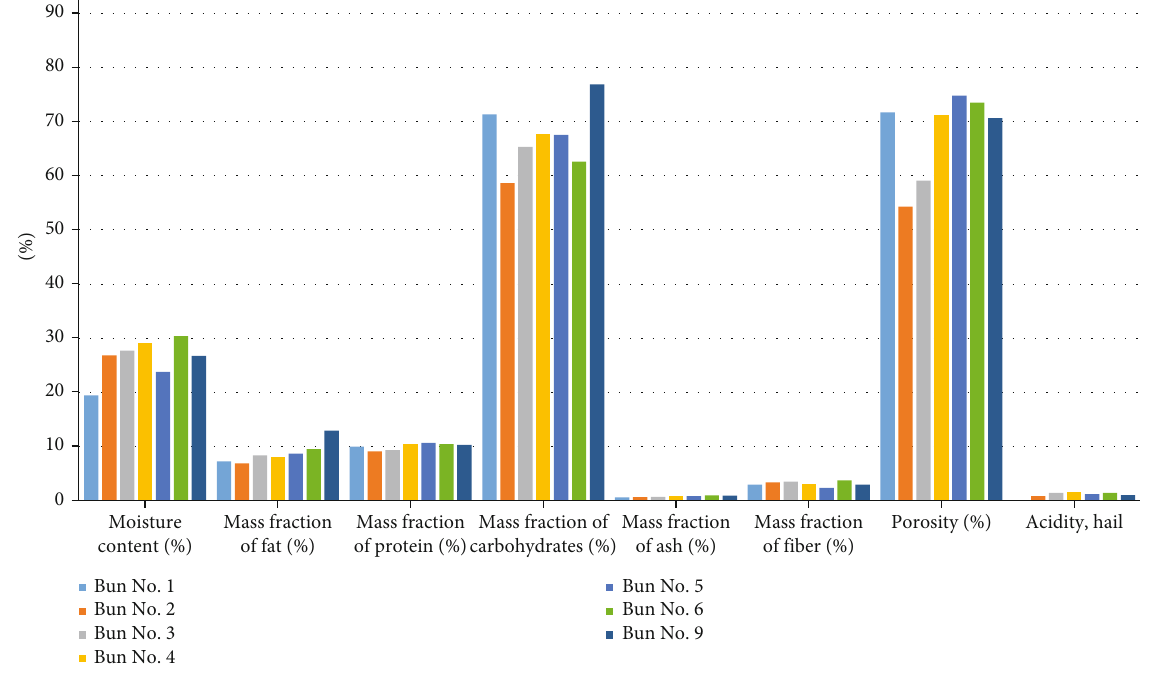
Figure 13: Physical and chemical indicators of various bun formulations.